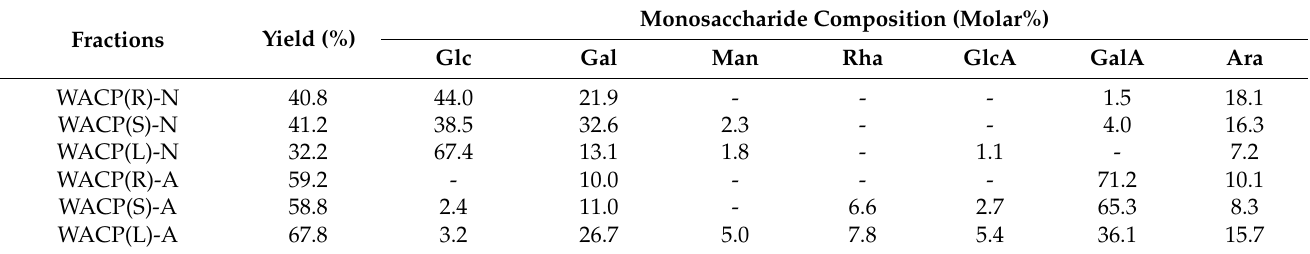
Table 2. Monosaccharide composition of six subfractions isolated from three tissues of Aralia continentalis